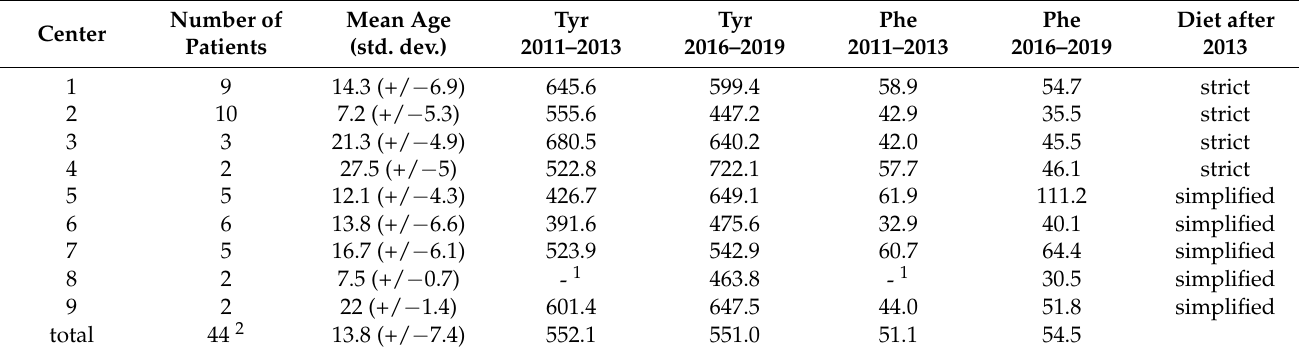
Table 3. Mean tyrosine (Tyr) and phenylalanine (Phe) concentrations in µ mol/L from the 2011–2013 (pre-workshop) and 2016–2019 periods